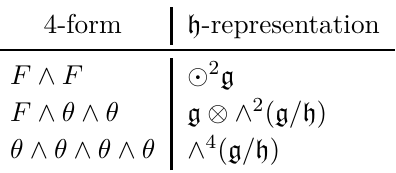
Table 4 . Four-forms (schematically) and their